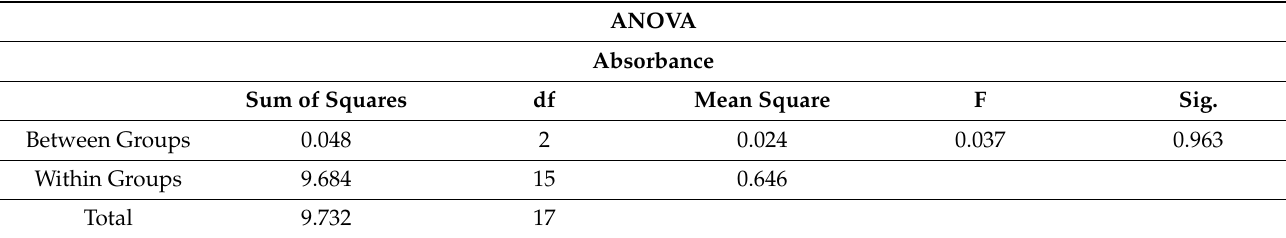
Table 4. One way ANOVA analysis.